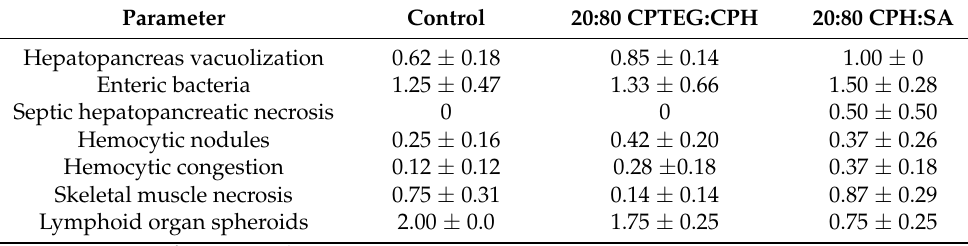
Table 3. Summary of histological findings in shrimp administered with 500 µ g of blank